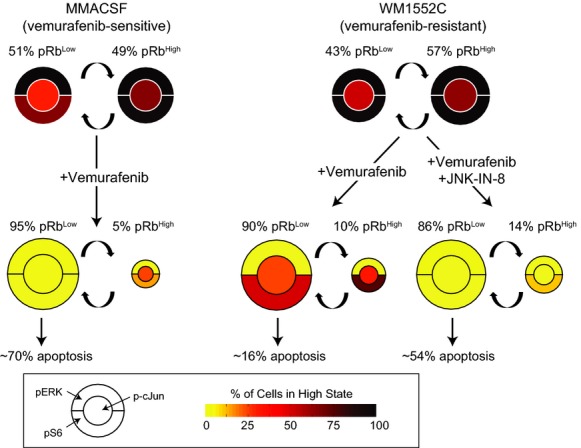
A schematic example representing c-Jun-mediated adaptive resistance to vemurafenib-induced apoptosisIn the sensitive cell line (e.g., MMACSF), vemurafenib shifts the majority of the cell population toward quiescence (represented as pRbLow cells) and fully inhibits pERK, p-cJun, and pS6 in these cells, leading to high levels of apoptosis. In the relatively resistant cell line with p-cJun up-regulation (e.g., WM1552C), vemurafenib significantly inhibits pERK and induces quiescence in the majority of cell population, but high levels of p-cJun lead to incomplete suppression of pS6 and protect cells from apoptosis. Combination of a selective JNK inhibitor, JNK-IN-8, with vemurafenib inhibits p-cJun and pS6 in quiescent cells and increases the fraction of apoptotic cells.